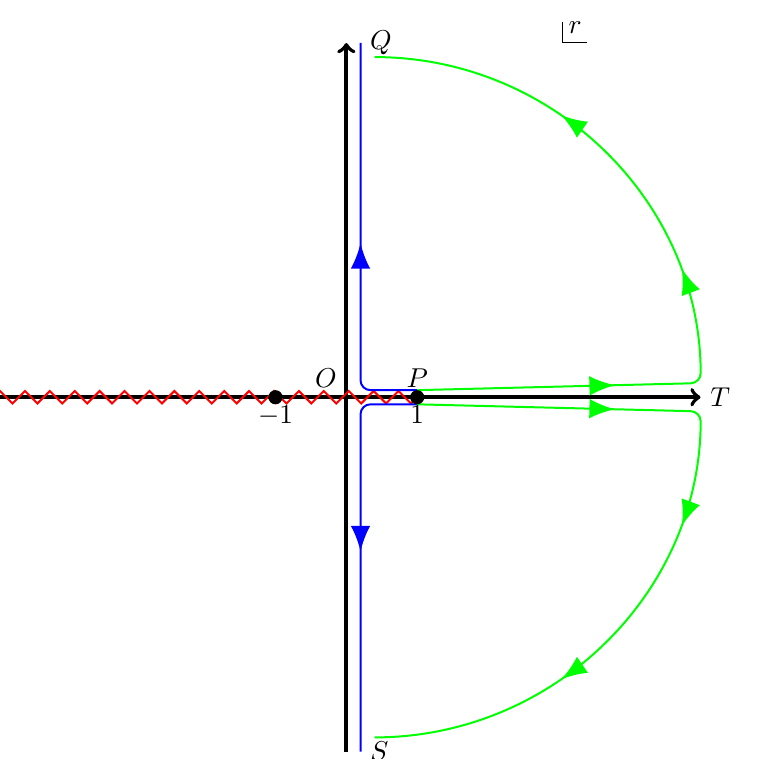
Figure 1 . Analytic continuations in the complex r-plane for the no-boundary